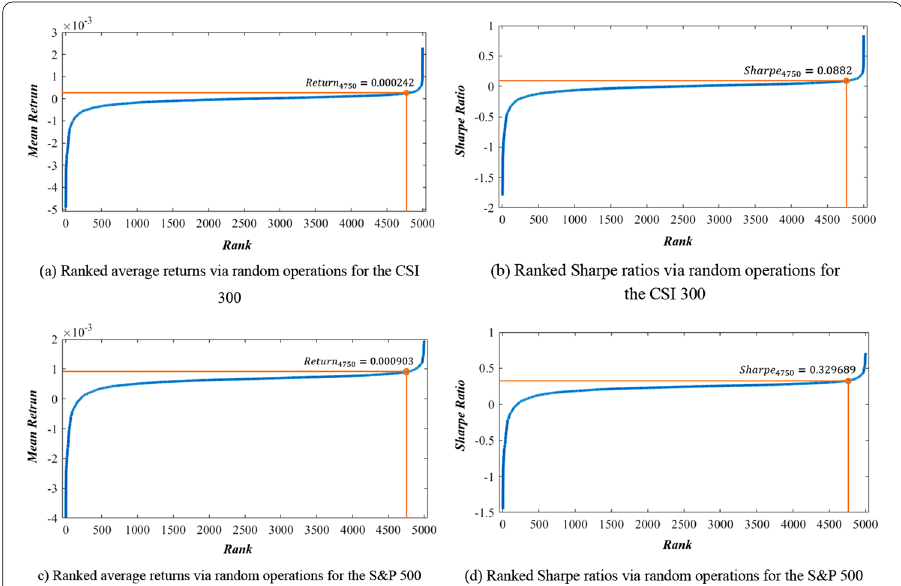
Fig. 10 The ranked mean returns and Sharpe ratios for each market via random investment